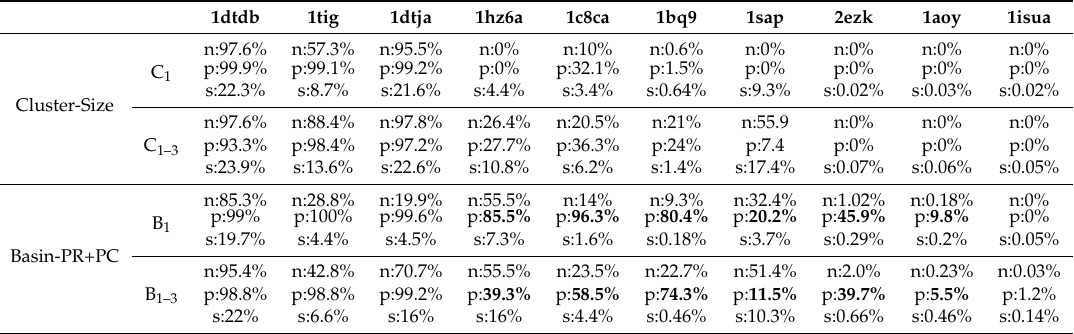
Table 2. Comparison of cluster-based and basin-based selection